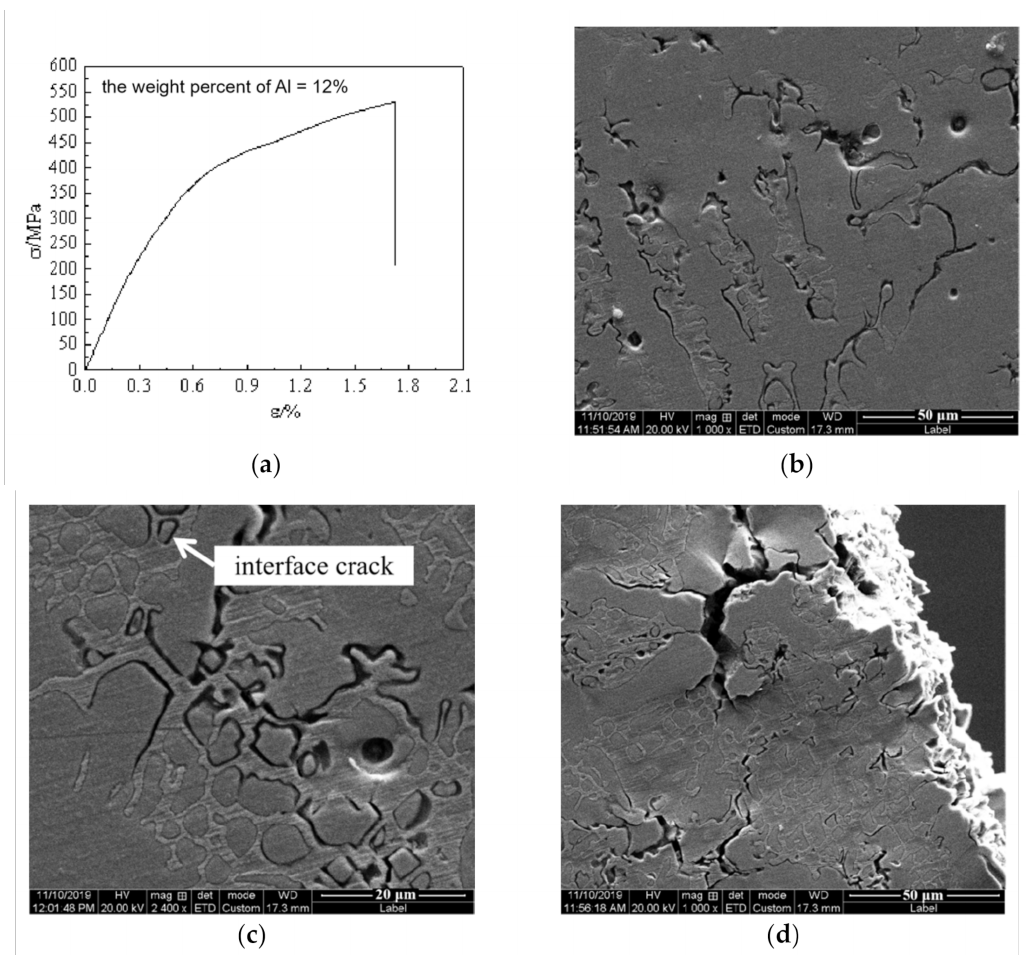
Figure 10. Crack evolution process of Fe-25Mn-12Al-8Ni-C alloy, ( a ) stress–strain curve; ( b ) ε = 1.7%, σ = 529.7 MPa, 1000 × . ( c ) ε = 1.7%, σ = 529.7 MPa, 2400 × ; ( d ) ε = 1.7%, σ = 529.7 MPa, 1000 ×